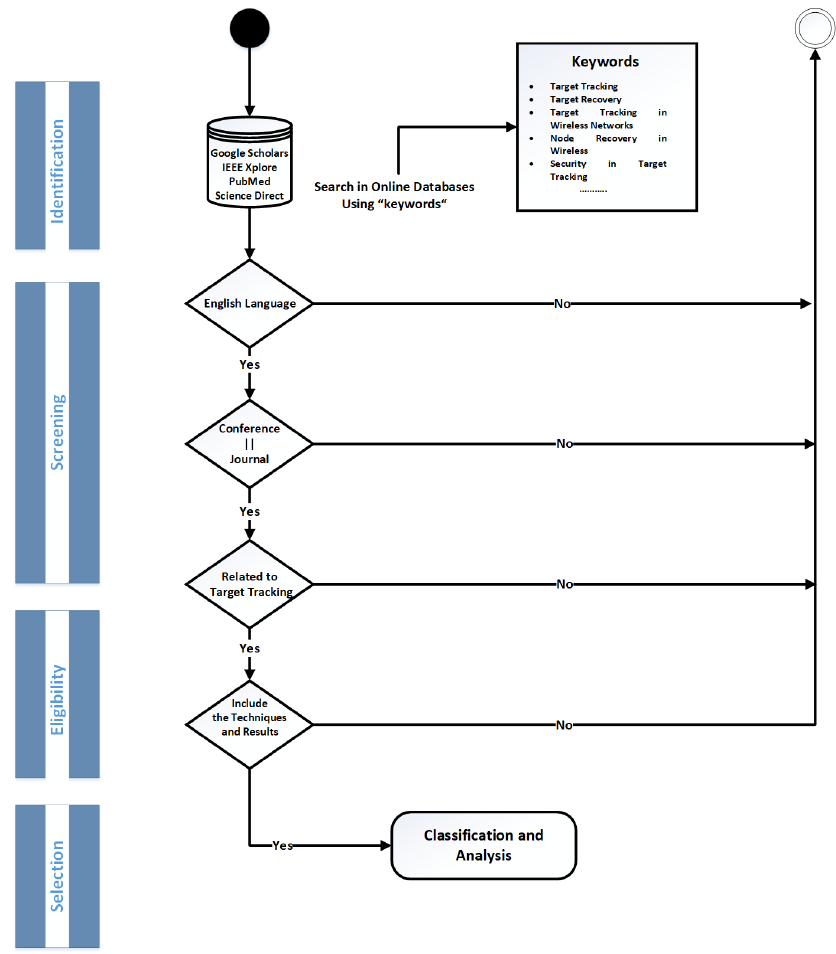
Figure 3. Proposed methodology.